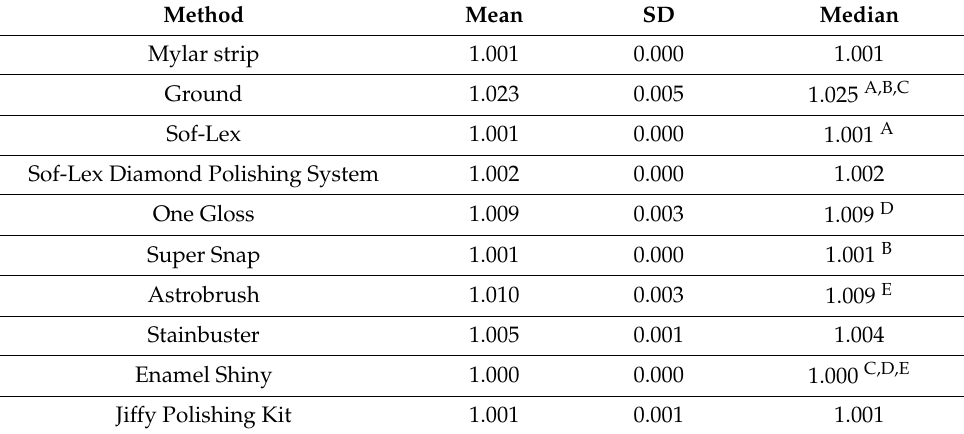
Table 5. Descriptive statistics, Rlr for Filtek